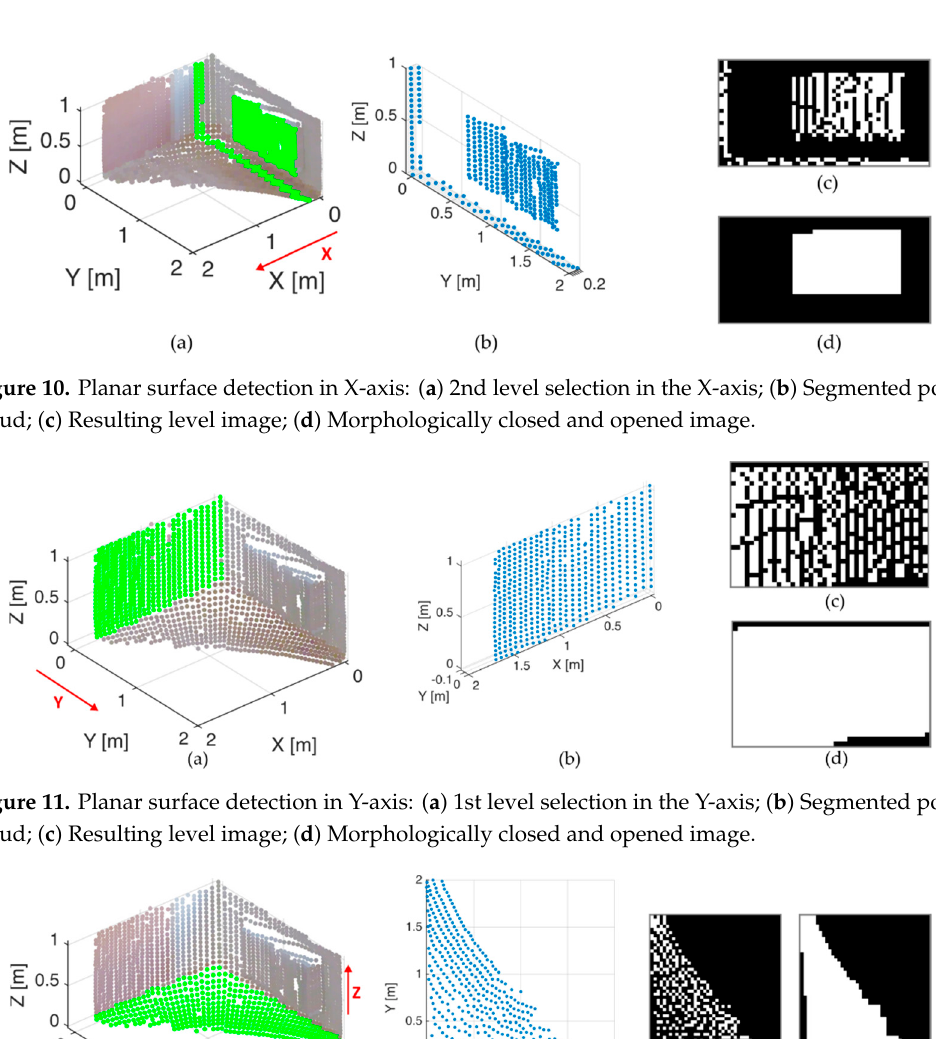
Figure 11. Planar surface detection in Y-axis: ( a ) 1 st level selection in the Y-axis; ( b ) Segmented point cloud; ( c ) Resulting level image; ( d ) Morphologically closed and opened image.